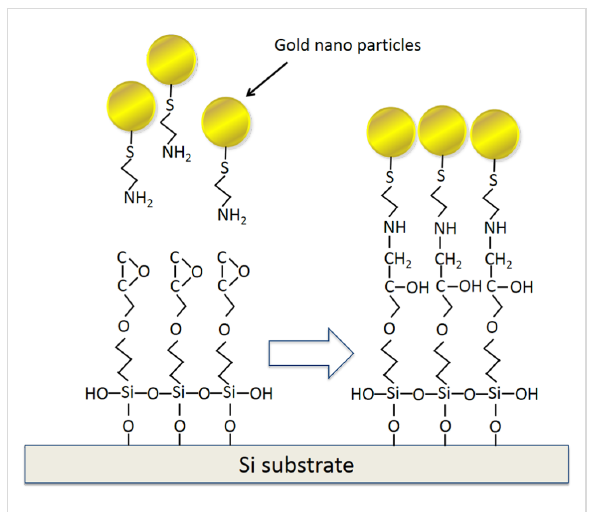
Figure 9: Schematic illustration of the formation of a two-dimensional, dense array of gold nanoparticles on a silicon substrate: step (i).